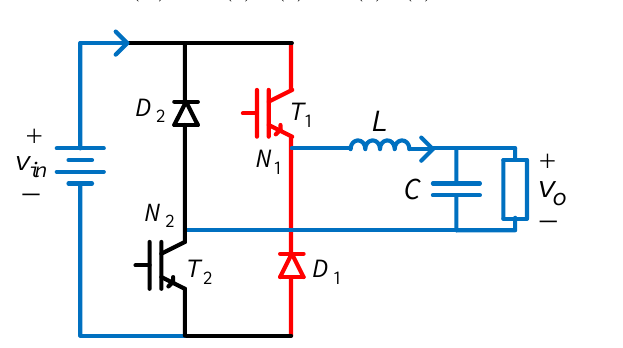
Figure 11. Voltage-fed DC-DC converter.